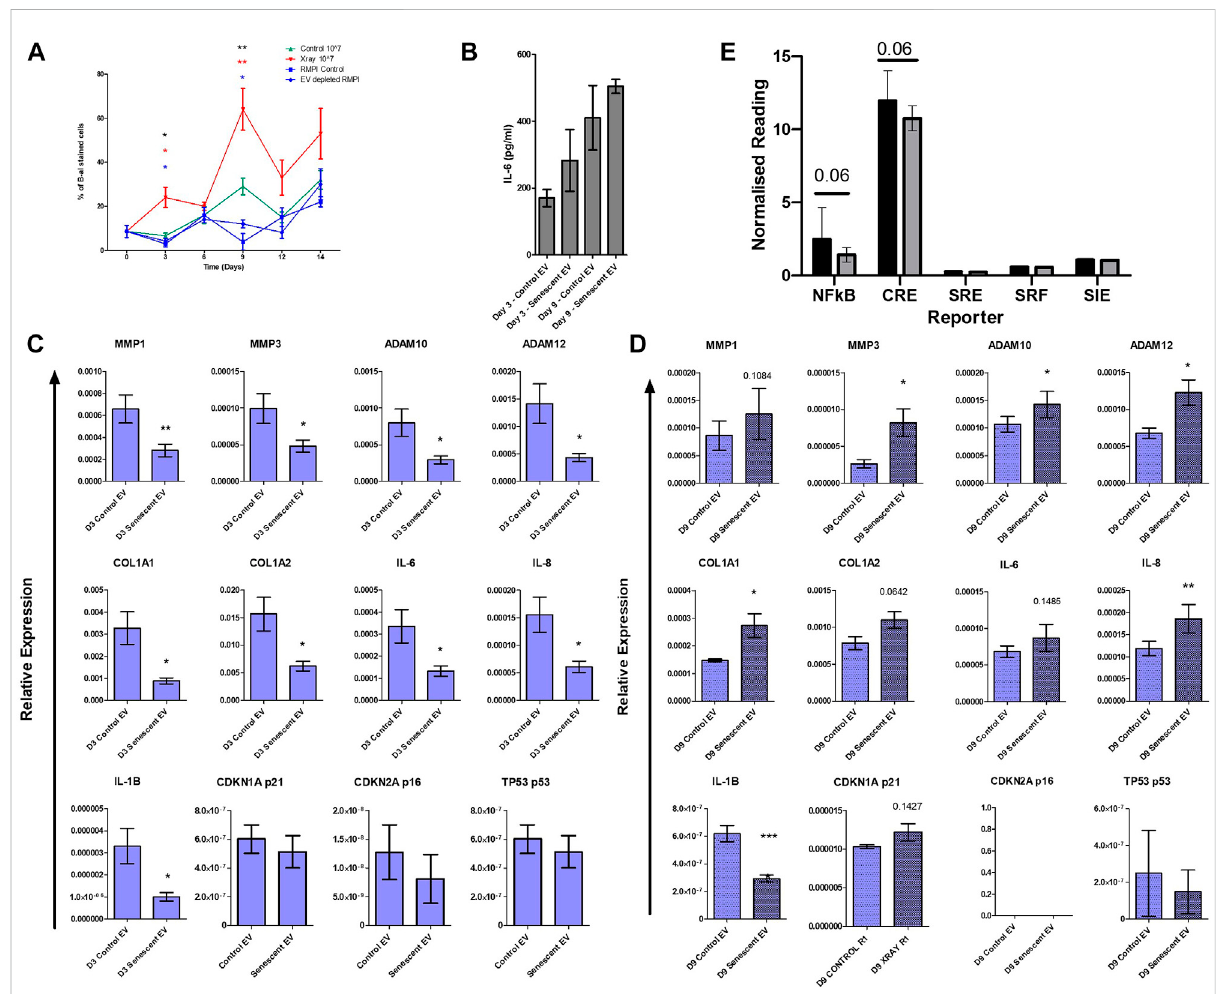
Isolated senescent EVs can induce bystander effect in non-senescent cells. (A) Percentage of senescence-associated β -galactosidase staining of senescent EV treated synovial fi broblasts over 14 days. N = 4. (black asterisks: RMPI Control vs. Senescent EV, red asterisks: EV depleted RMPI vs. Senescent EV, blue asterisks: Control EV vs. Senescent EV). (B) Senescence associated secretory phenotype (SASP) determined by IL-6 ELISA at day 3and day9ofEVtreatment(N=6). (C,D) SASPandsenescentEVassociated genesofinterestquanti fi edbyRT-PCR(N=6). (E)